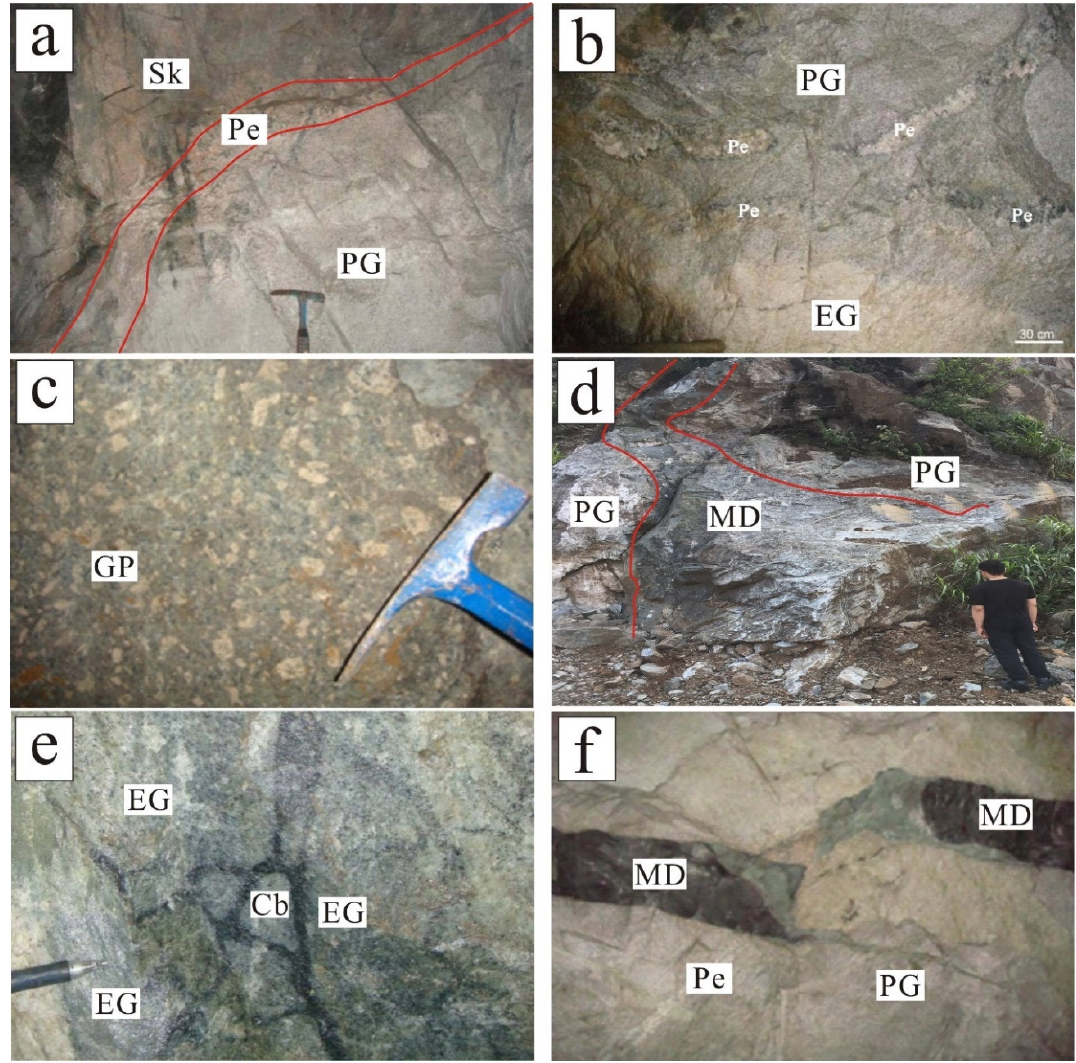
Figure 3. Photographs of the Qianlishan complex: ( a ) porphyritic granite and banded pegmatitic edge; ( b ) pegmatitic schlieren in porphyritic granite; ( c ) granite porphyry; ( d ) mafic dyke intruded into porphyritic granite; ( e ) cryptoexplosive breccia in equigranular granite; and ( f ) mafic dyke cut through the main-phase granite. Abbreviations: PG: porphyritic granite; EG: equigranular granite; GP: granite porphyry; MD: mafic dykes; Sk: skarn; Pe: pegmatite; and Cb: cryptoexplosive breccia.